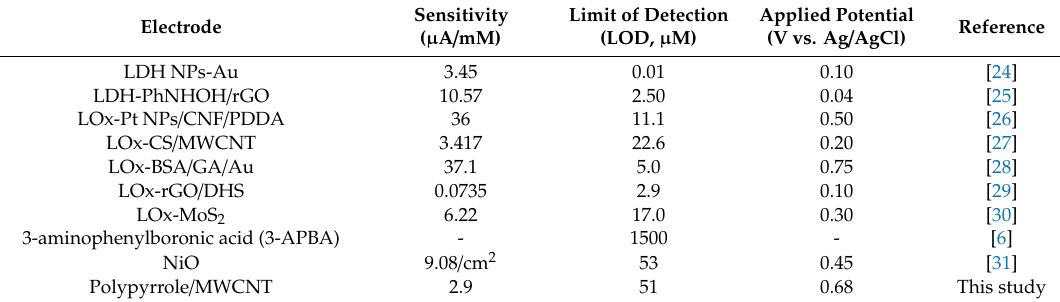
Table 1. Comparison of analytic parameters of various lactate biosensors.